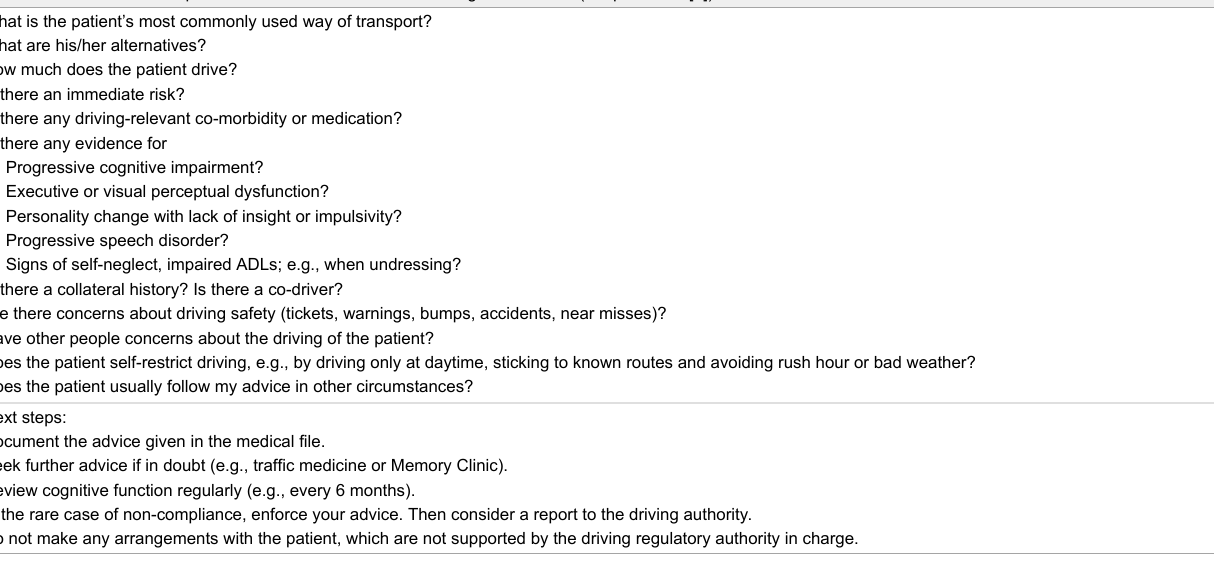
Table 2: Questions and steps to consider for GPs when assessing older drivers (adapted from